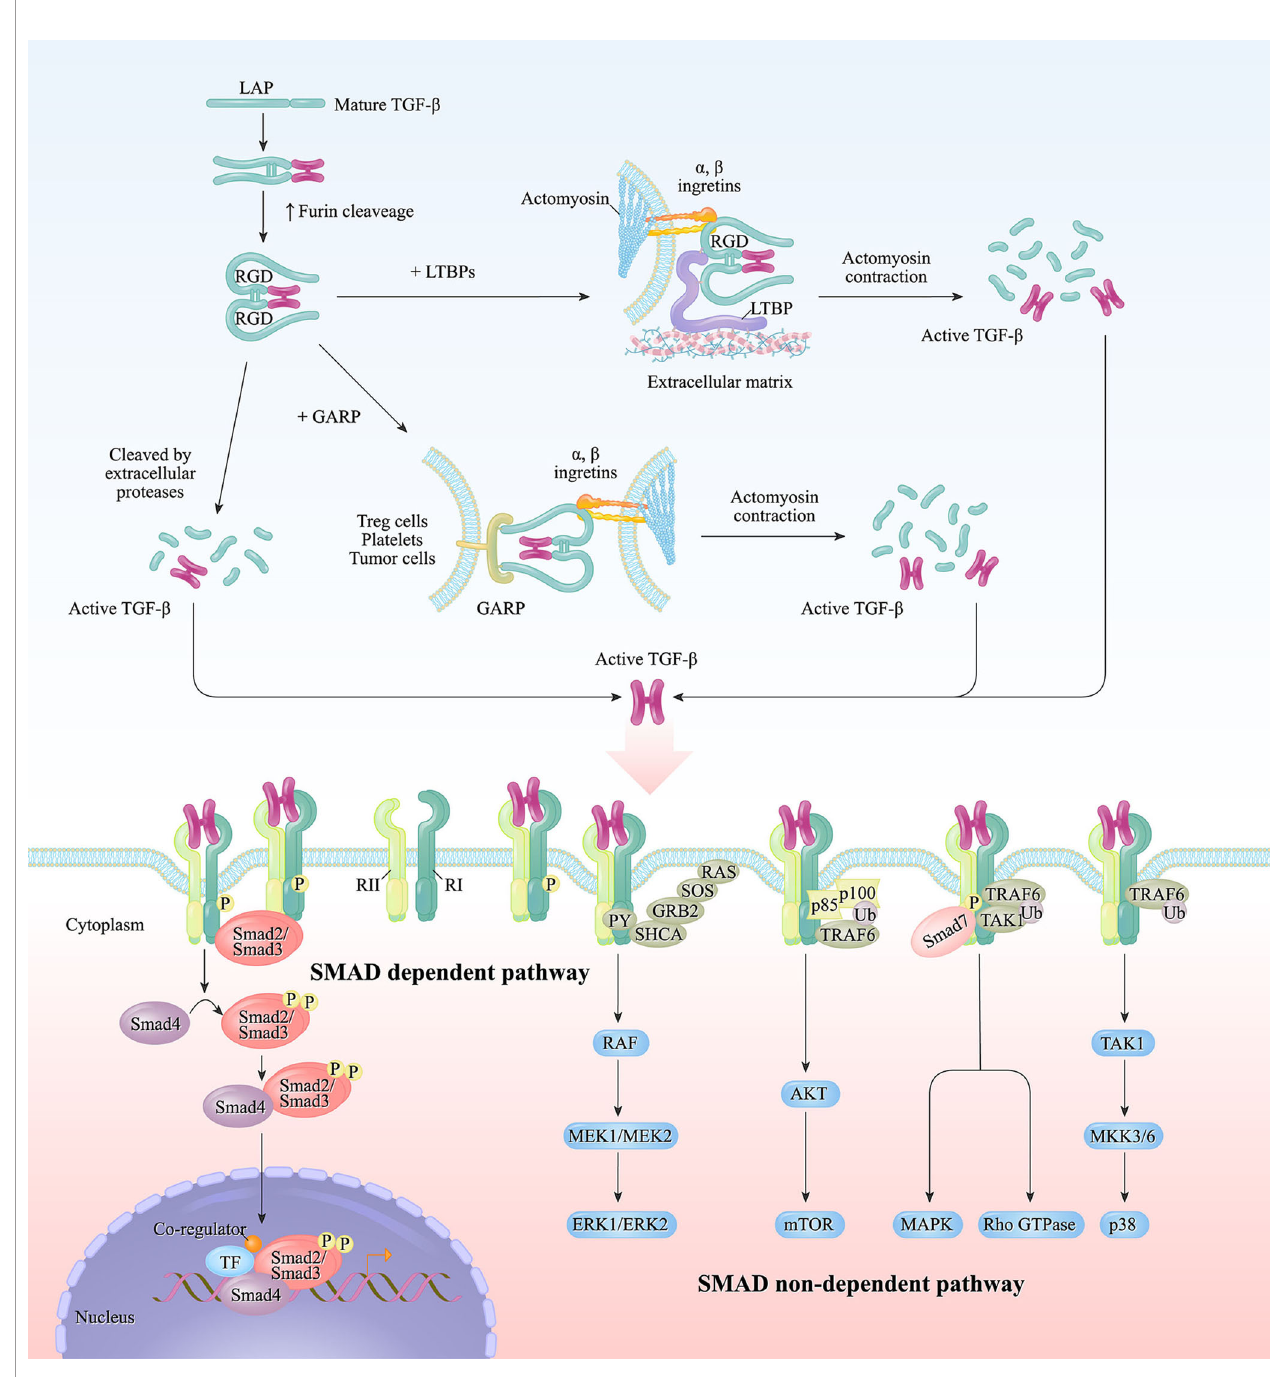
FIGURE 1 | Canonical and noncanonical TGF- b signaling. Engagement between TGF- b and its receptor initiates canonical and non-canonical signaling pathways. The mature fragment of TGF- b 1 remains associated with latency-associated peptide (LAP) at N-terminal propeptide. LTBPs (latent transforming growth factor b binding proteins) from the extracellular matrix (ECM) form the large latent complex (LLC) with TGF- b in the endoplasmic reticulum. When TGF- b was released and recognized by receptors, it subsequently stimulates the canonical and non-canonical pathways in cells through separate mechanisms. In canonical signaling, which is also called the SMAD-dependent pathway, the receptor activation triggers a cascade of SMAD proteins phosphorylation and translocation into the nucleus, thus promoting the downstream gene expression. While in non-canonical signaling, the receptor ligation leads to SMAD non-dependent pathway activation, including MEK/ERK pathway, AKT pathway, MAPK, and p38